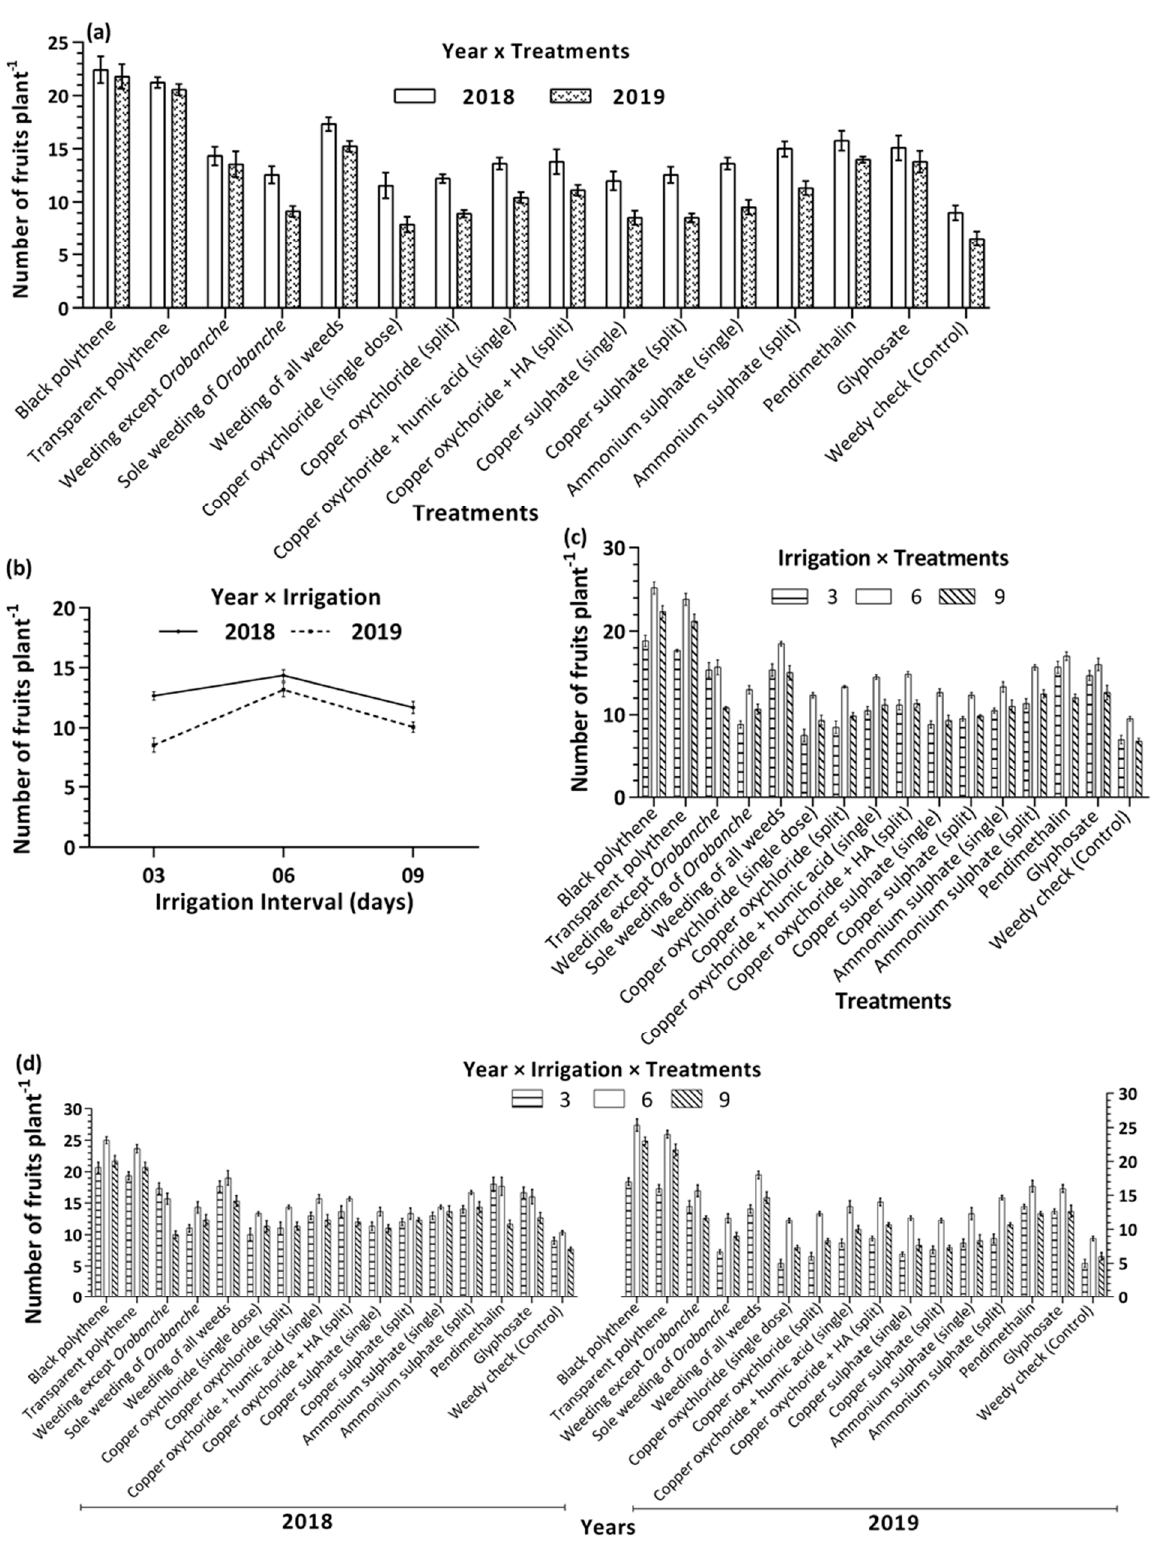
Figure 12. Impact of various interactions on the number of fruits plant − 1 of tomato. ( a ) Interaction effect of year × treatments on the number of fruits plant − 1 . ( b ) Interaction effect of year × irrigation number of fruits plant − 1 . ( c ) Interaction effect of irrigation × treatments on the number of fruits plant − 1 . ( d ) Interaction effect of year × irrigation × treatments on the number of fruits plant − 1